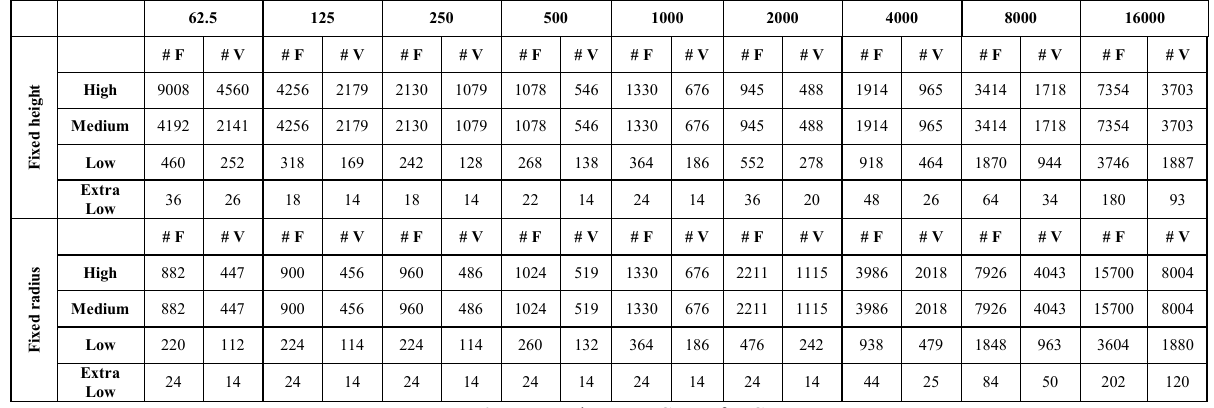
Table 3. Face and Vertex Count for Cones